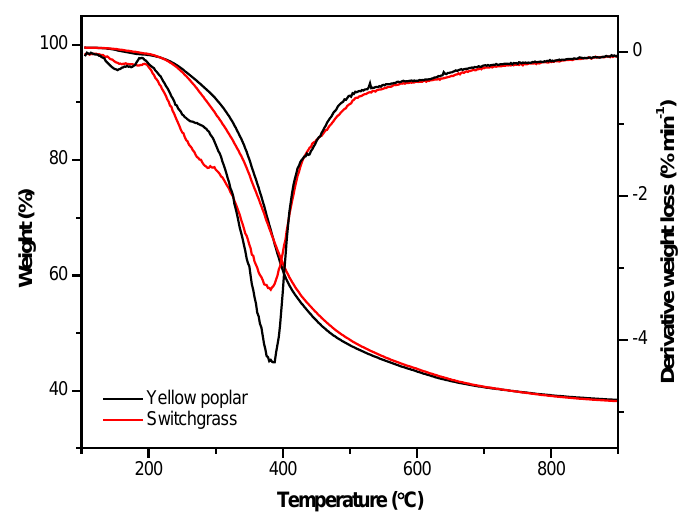
Figure 2. Thermal decomposition of switchgrass and yellow poplar lignins.